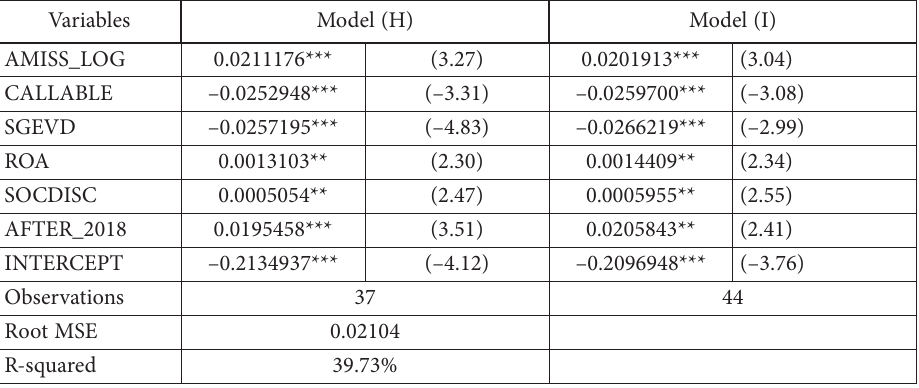
Table 8. Alternative regressions on abnormal issuer announcement returns (source: own